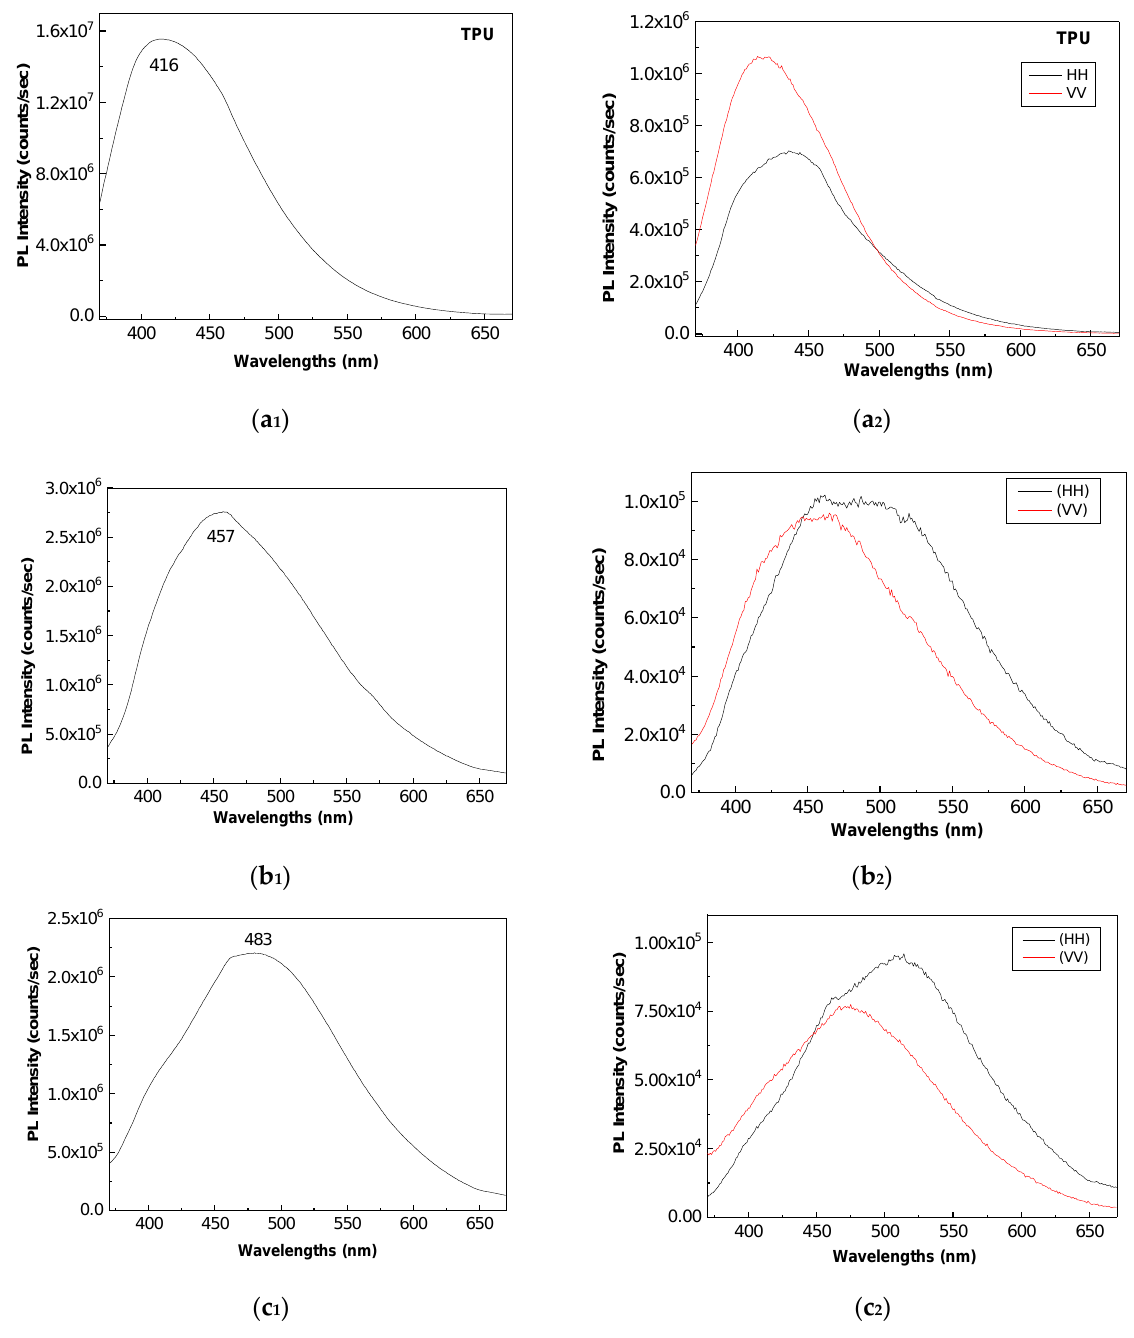
Figure 7. PL spectra of TPU ( a 1 ), PTU – TiO 2 NWs 2% ( b 1 ), and PTU – TiO 2 NWs 17% ( c 1 ). Anisotropic PL of TPU ( a 2 ), PTU – TiO 2 NWs 2% ( b 2 ), and PTU – TiO 2 NWs 17% ( c 2 ). In ( a 2 , b 2 , c 2 ), blue and red curves correspond to PL spectra recorded when measurement geometry for emission and excitation polarizers are both in horizontal (HH) and vertical (VV) position.